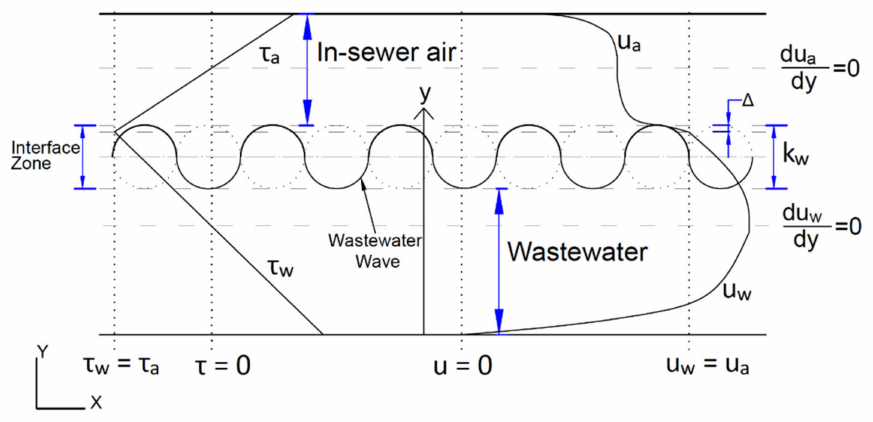
Figure 7. Velocity and shear stress boundary layers in a sewer pipe. τ is the shear stress (N/m 2 ), u is the velocity (m/s), a and w denote the in-sewer air and wastewater, respectively, ∆ is the distance from the zero-velocity plane to the maximum height of the wastewater surface wave (m), y is the relevant vertical distance from the relevant zero-velocity plane (m), k W is the wastewater surface wave amplitude